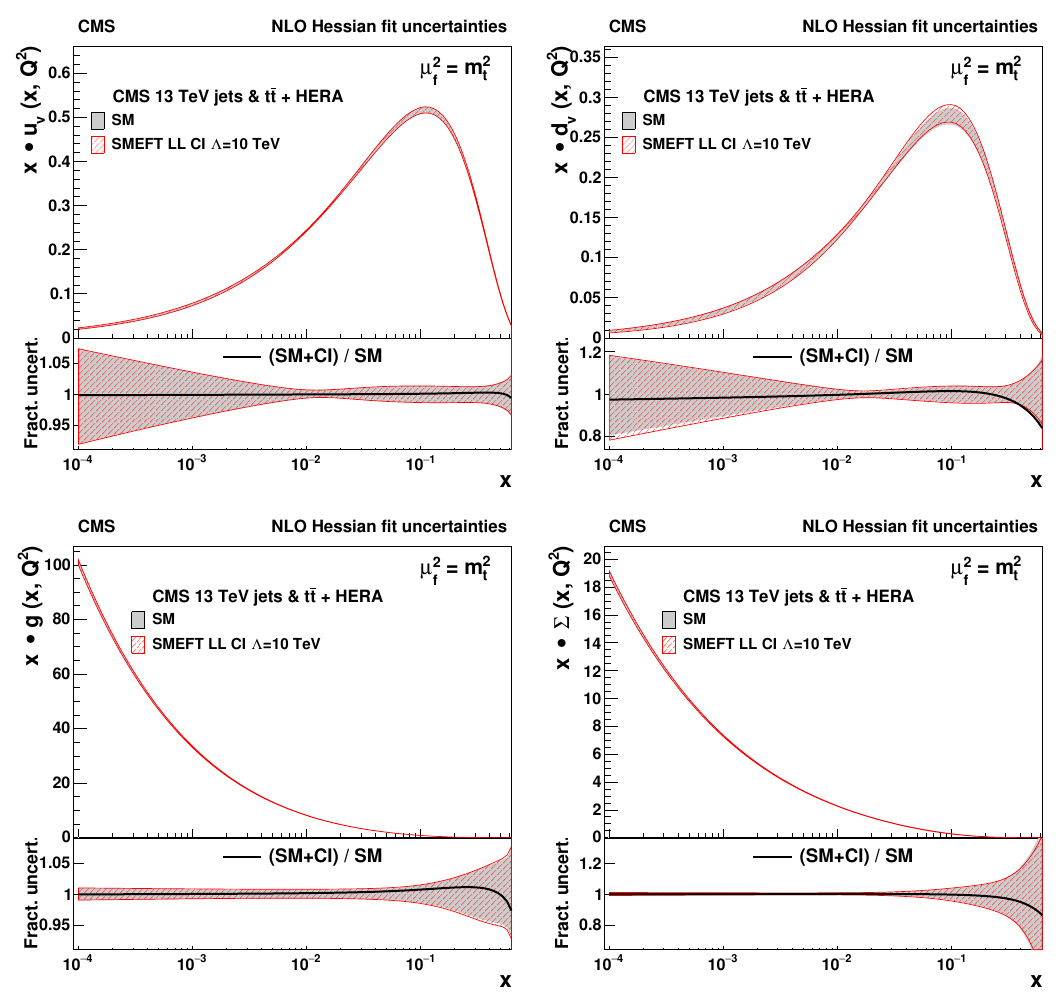
Figure 17 . The u -valence (upper left), d -valence (upper right), gluon (lower left), and sea quark (lower right) distributions, shown as functions of x at the scale µ 2 with and without the CI terms. The SMEFT fit is performed with the left-handed CI model with Λ = 10